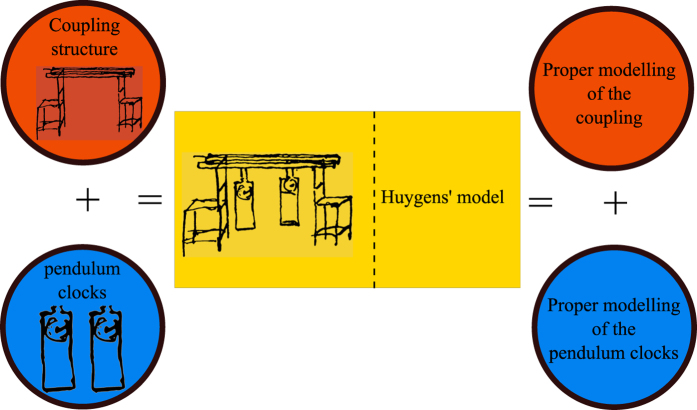
Huygens’ setup (see125).